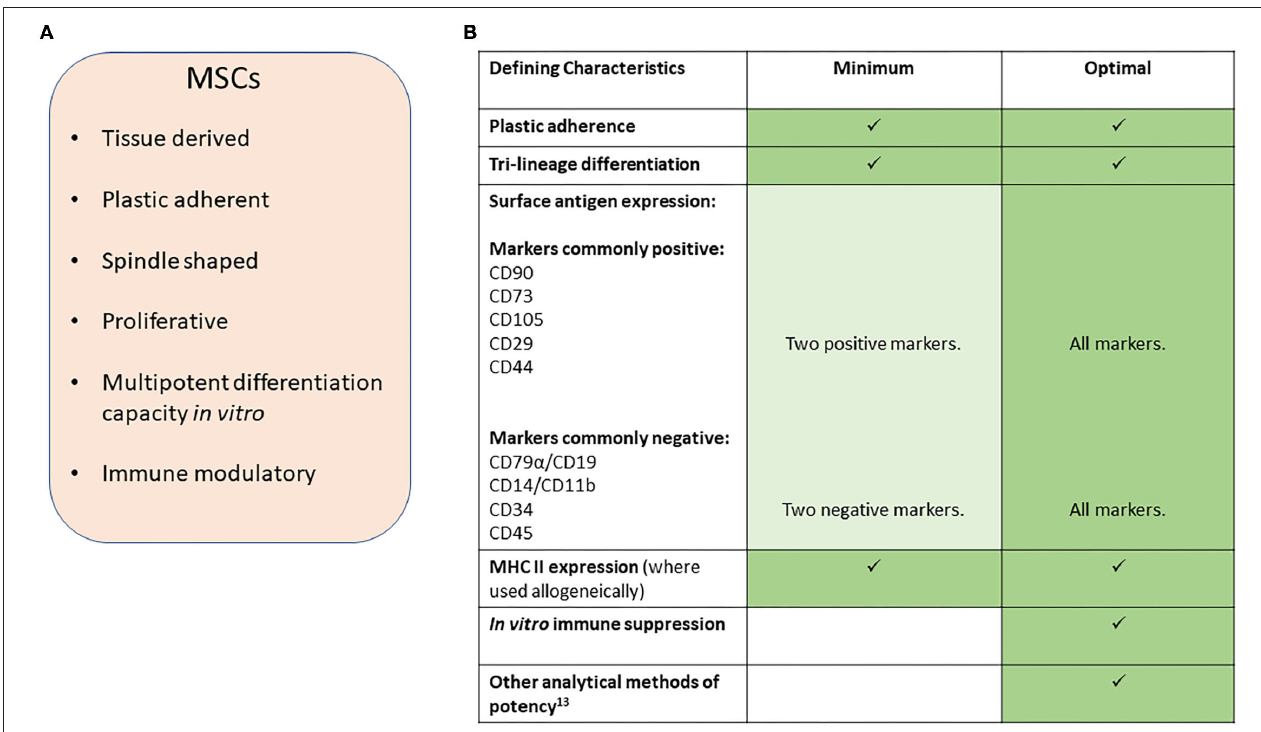
FIGURE 1 | (A) Characteristics of MSCs. (B) Suggested minimal and optimal definitions of equine and canine